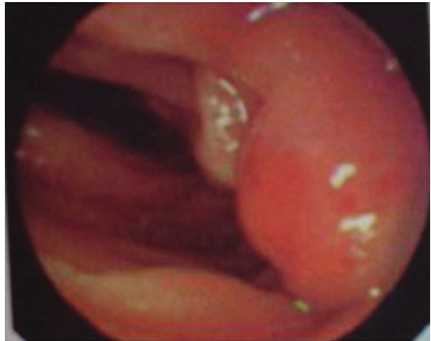
Figure 2: Upper endoscopy showing an obstructive and exudative mass between the second and third parts of duodenum.